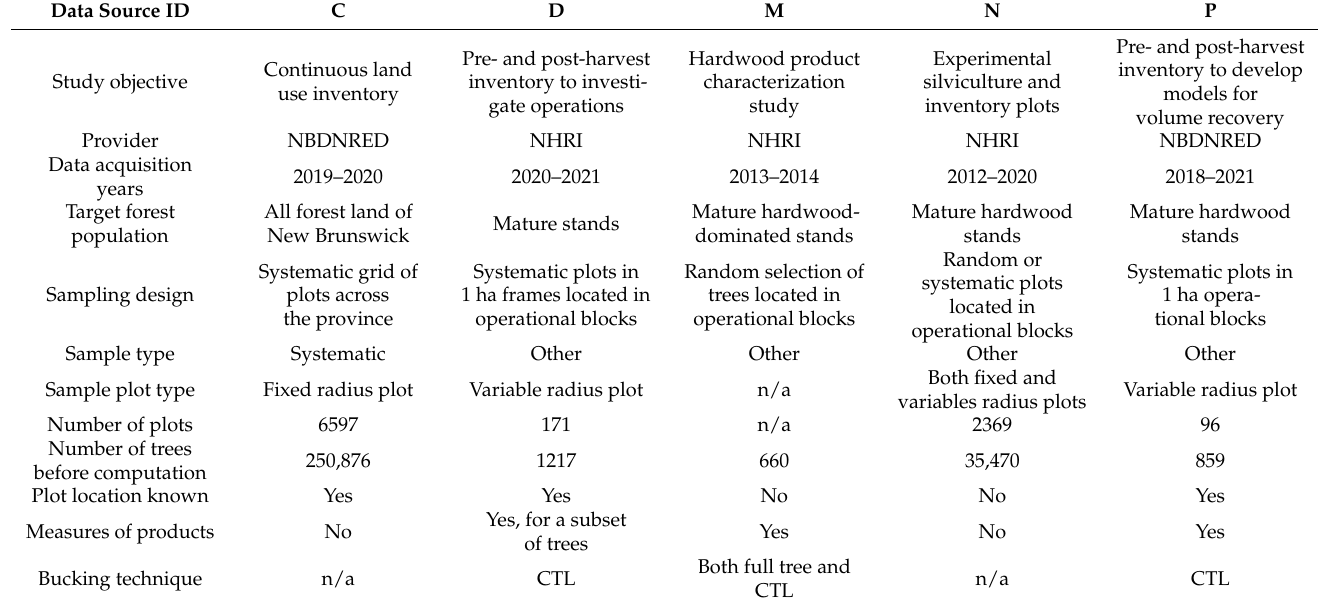
Table 1. Overview of different data sources used for this